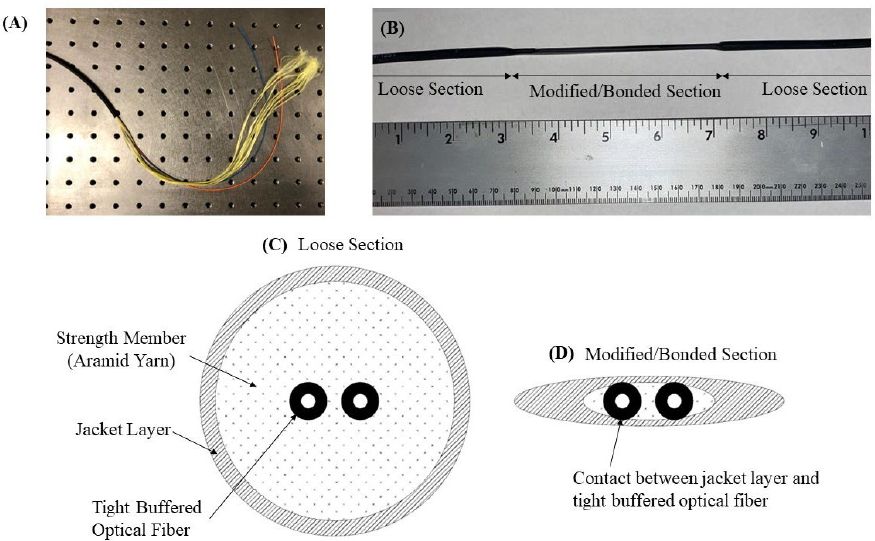
Figure 5. ( A ) The commercially available standard fiber optic cable (note loose contact between optical fibers (orange and blue) and jacket material (black) due to the presence of the aramid yarn (yellow) strength member), ( B ) The profile of the modified hybrid cable showing an interval bonded section where the jacket has been heated and pressed to contact the tight buffered optical fibers, ( C ) A cross section of the standard optical fiber cable and loose section of the hybrid fiber optic cable, ( D ) A cross section of the interval bonded section of the hybrid fiber optic cable (note the contact between the jacket material and the tight buffered optical fibers).